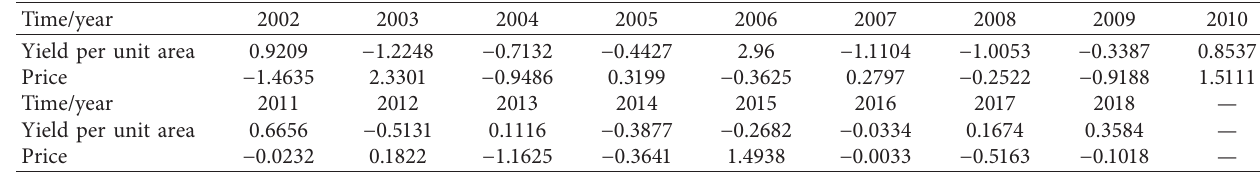
Table 1: Z -score normalized data of fluctuation items in yield per unit area and price of jujube in Aksu region.